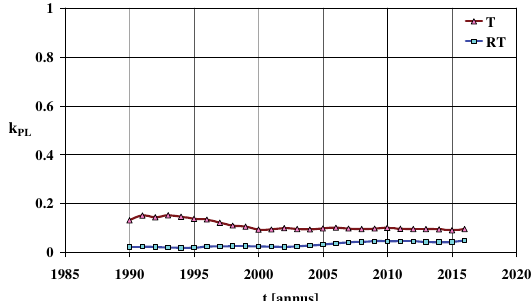
Fig. 10. Share of annual emission in Poland comparing to the annual emission in the European Union for total suspended particles: for total